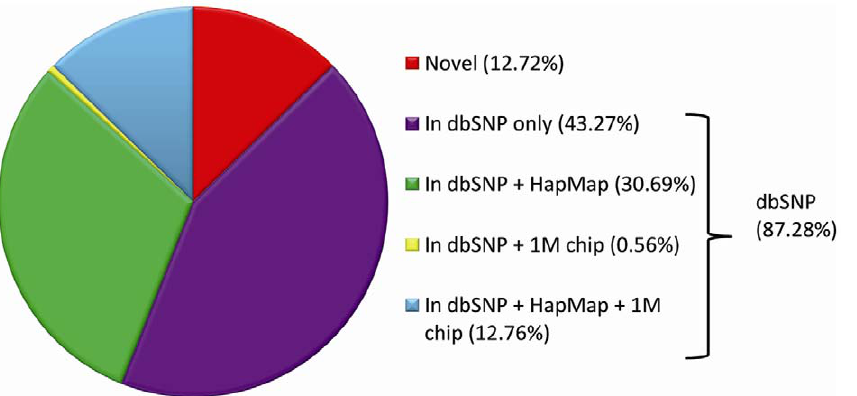
Figure 1. Average per-genome overlap between SNVs in genomic databases and SNVs identified by whole-genome sequencing. On average, 3,473,639 SNVs were observed in each genome (Table S2). A per-genome average of 87.28% of these SNVs were present in the dbSNP database (version 129, validated) (Table S3).